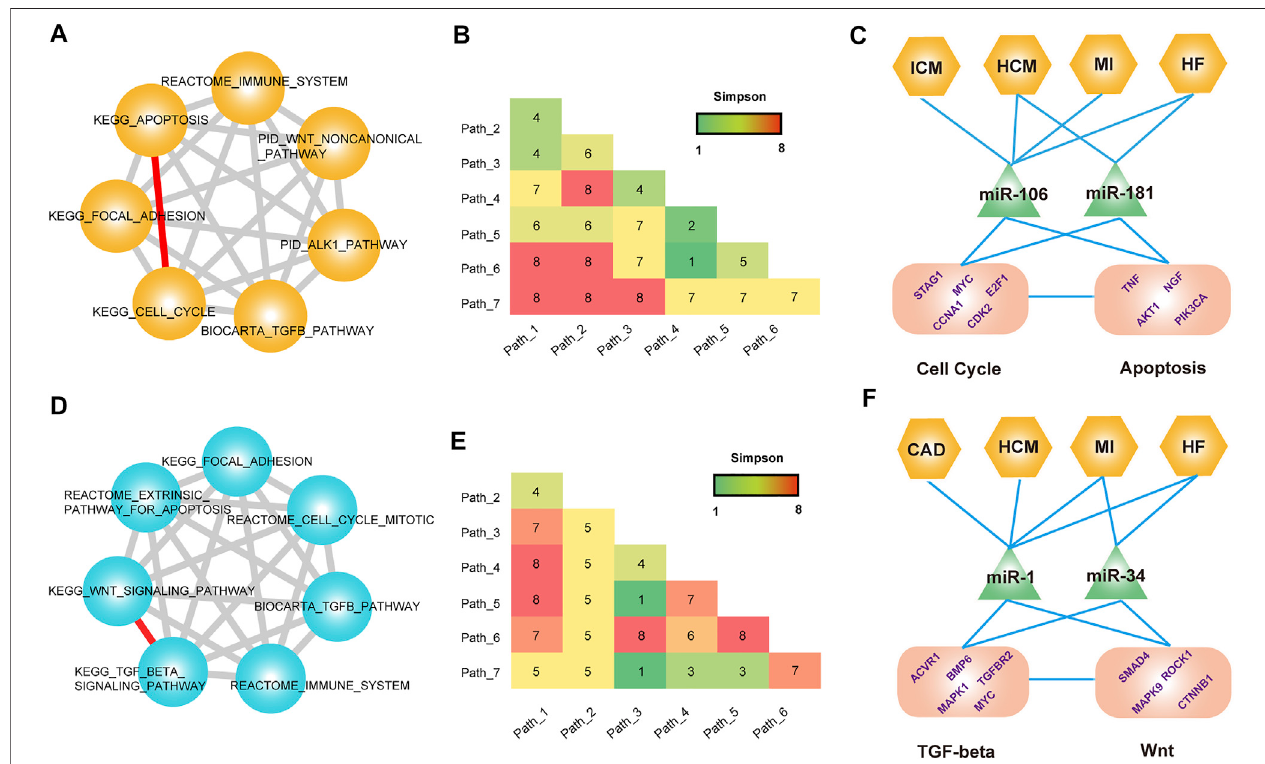
FIGURE 6 | Common modules across CVDs . (A) A module that contained seven pathways. (B) Distribution matrix represents the number of CVDs occurring in each pathway crosstalk pair. (C) Multi-level analysis of the module. (D – F) Analysis of another module that contains seven pathways.